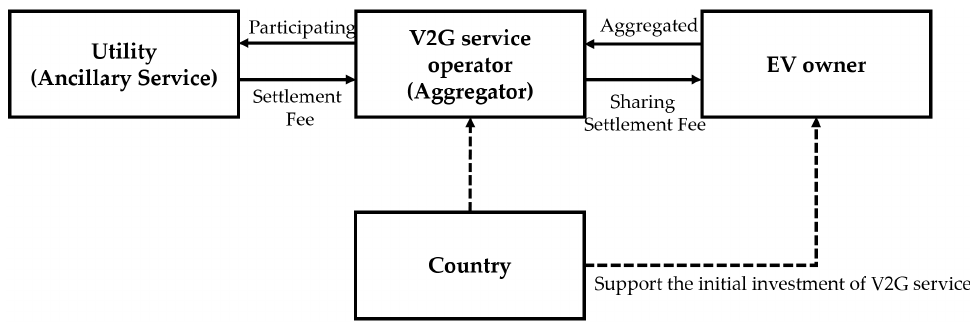
Figure 6. Stakeholders and business model. Table 3. The benefits and costs for each stakeholder.